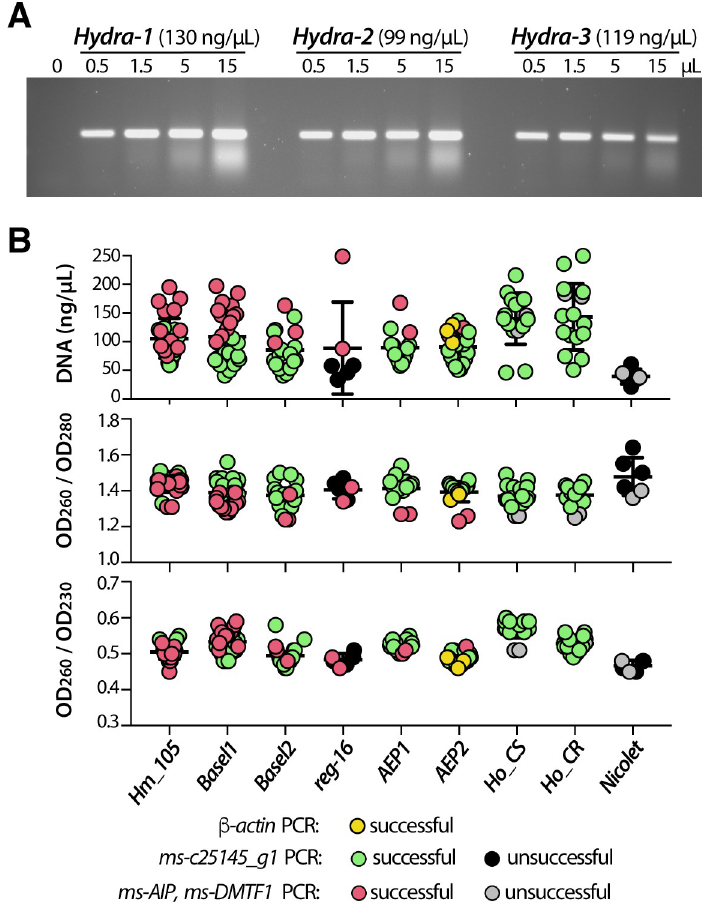
Fig 2. Direct genomic DNA amplification from single Hydra polyp. (A) PCR amplification of β -actin genomic DNA from three 4–6 mm long, non-budding AEP animals dissociated and resuspended each in 50 μ l water. Various amounts (from 0 to 15 μ L) of the resulting macerates were used as PCR template for β -actin amplification to estimate PCR efficiency. (B) Graphic representation of DNA concentration and DNA purity as deduced from OD measurements at 260, 230 and 280 nm wave lengths. Each dot represents either the OD260 value or the 260/280 or 260/230 OD value ratios obtained from a single polyp. For each DNA, the efficiency of PCR amplification is indicated with a color code. Note the lower DNA content in most reg-16 polyps that were fixed in PFA and stored in methanol for months prior to rehydration, maceration and DNA amplification.